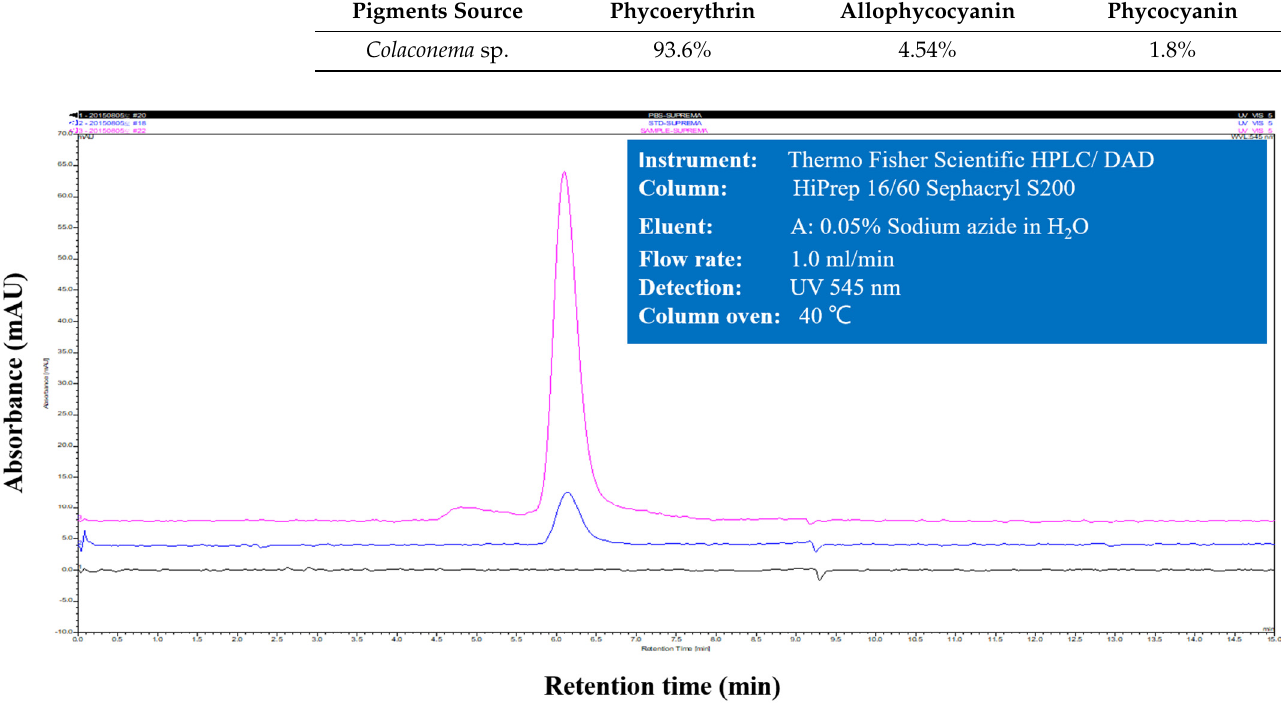
Animals 2021 , 11 , x Figure 2. Absorption spectrum of phycoerythrin (PE) purified by size exclusion chromatography in HPLC using a HiPrep Sephacryl S-300 HR column (Pink line: Colaconema sp.-PE; blue line: standard-PE; black line: PBS buffer).